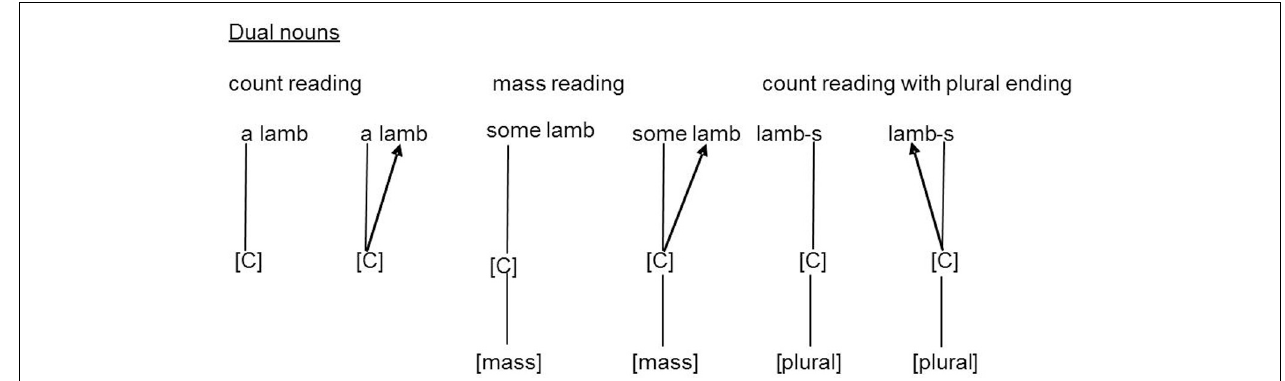
FIGURE 2 | Application of the lexical rule “countability by context” adapted from Taler and Jarema (2006, Figure 5, page, 50). Representation of the lexical-syntactic specification of dual nouns for countability by determiners or affixes during bare noun/noun phrase processing. The lexical-syntactic information [C] (count) or [mass] of